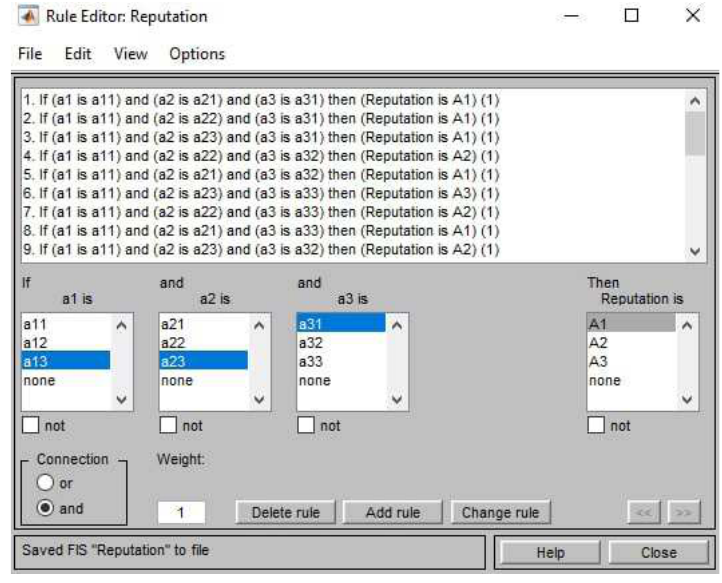
Figure 5. Fragment of the rule base for obtaining the intermediate parameter company